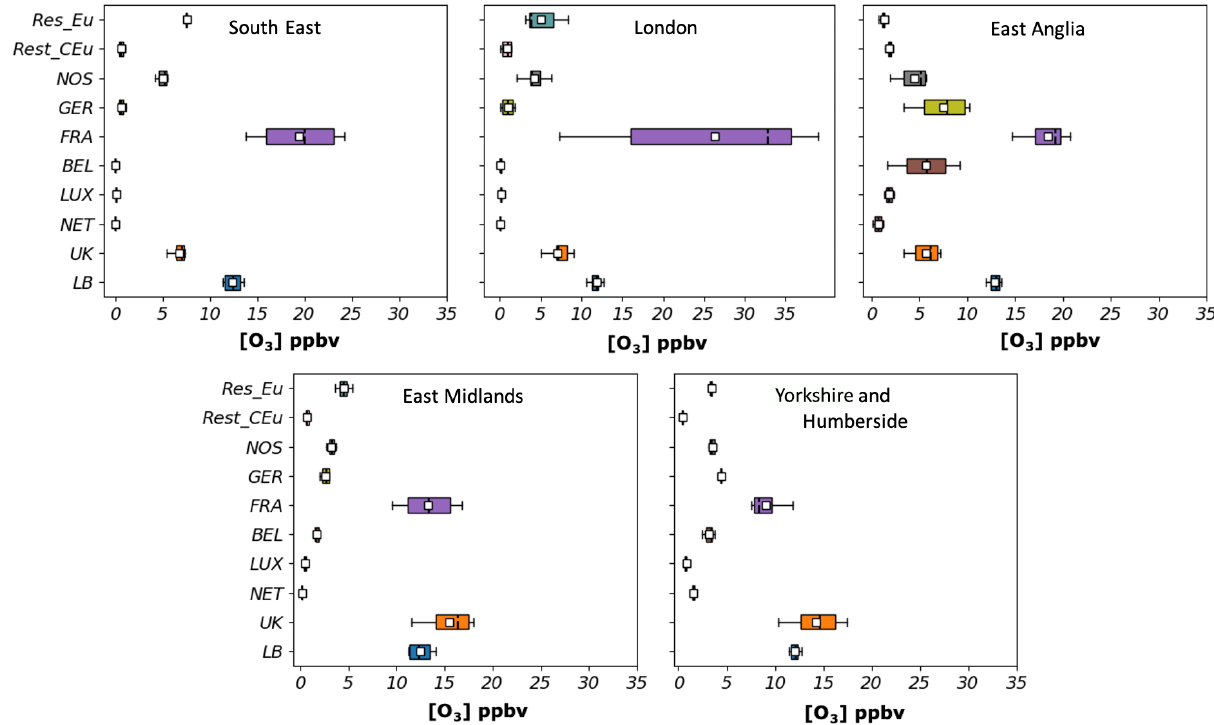
Figure 11. Hourly contributions (in ppbv) to surface O 3 at 5 UK receptor regions from 10 source regions (UK, background (LB), the Netherlands, Luxembourg, Belgium, France, Germany, the rest of central Europe (Rest_CEu), the North Sea and English Channel (NOS), and the rest of Eu) during days when the MDA8 is above 60ppbv between May and August. The lower and upper ends of the boxes indicate the 25th and 75th percentiles, the dashed black line the median, the white boxes the mean, and the whiskers the minima and maxima.